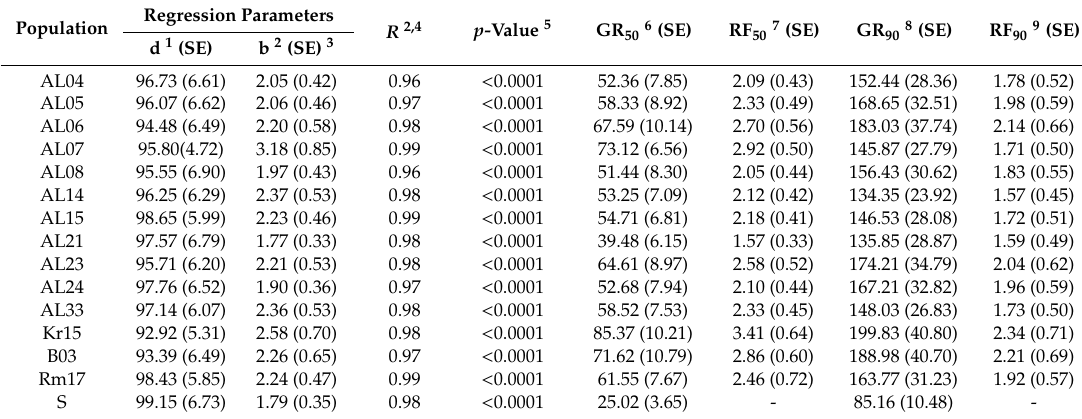
Table 6. Estimated non-linear regression parameters for the P. brachystachys populations in response to pinoxaden, based on the dry